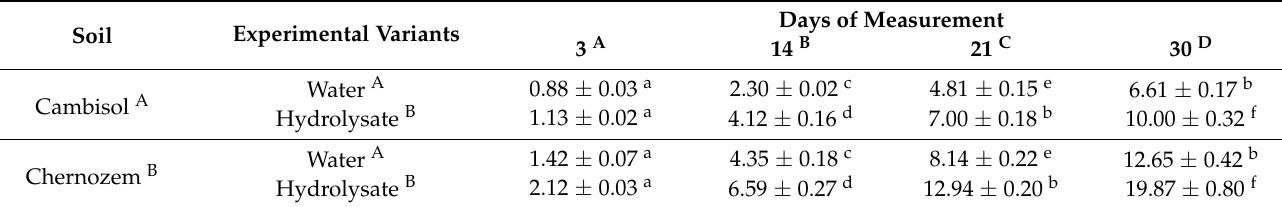
Table 2. Dynamic of changes in Brassica napus L. var. napus